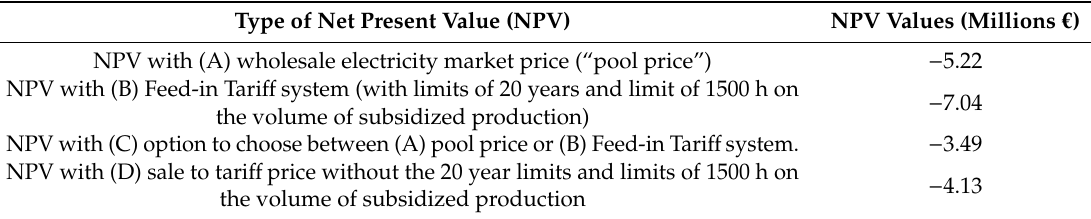
Table 5. Average values of the NPVs to calculate the options